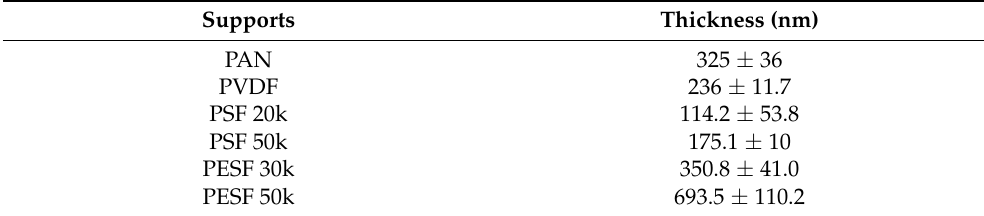
Table 3. The selective layer thicknesses of PVA TFC membranes fabricated on different supports. Supports